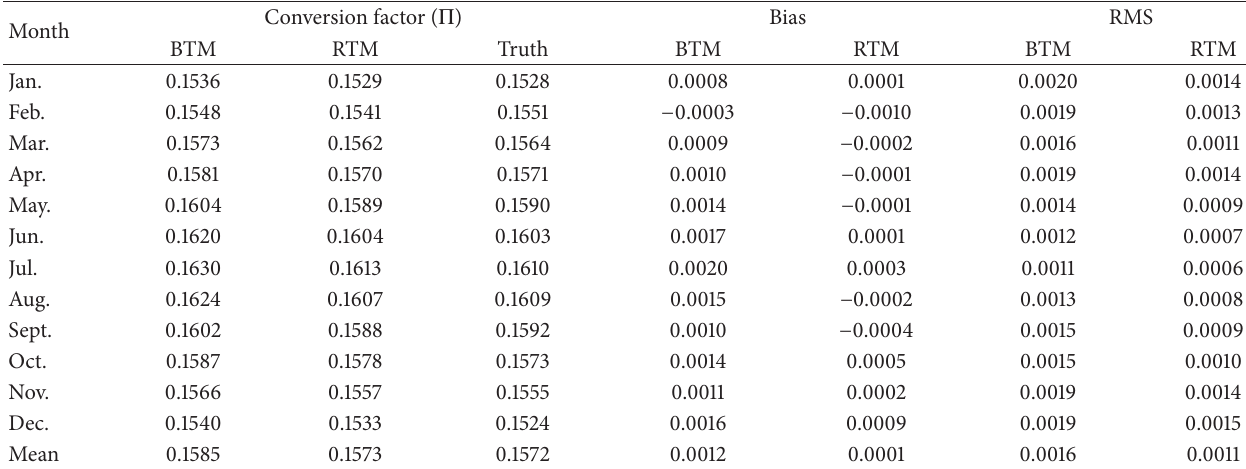
Table 6: Bias and RMS of conversion factor ( ^ ) resulting from the BTM and seasonal two-factor RTMs against the truth of ^ during 2013- 2014. Conversion factor ( ^ ) Bias RMS Month BTM RTM Truth